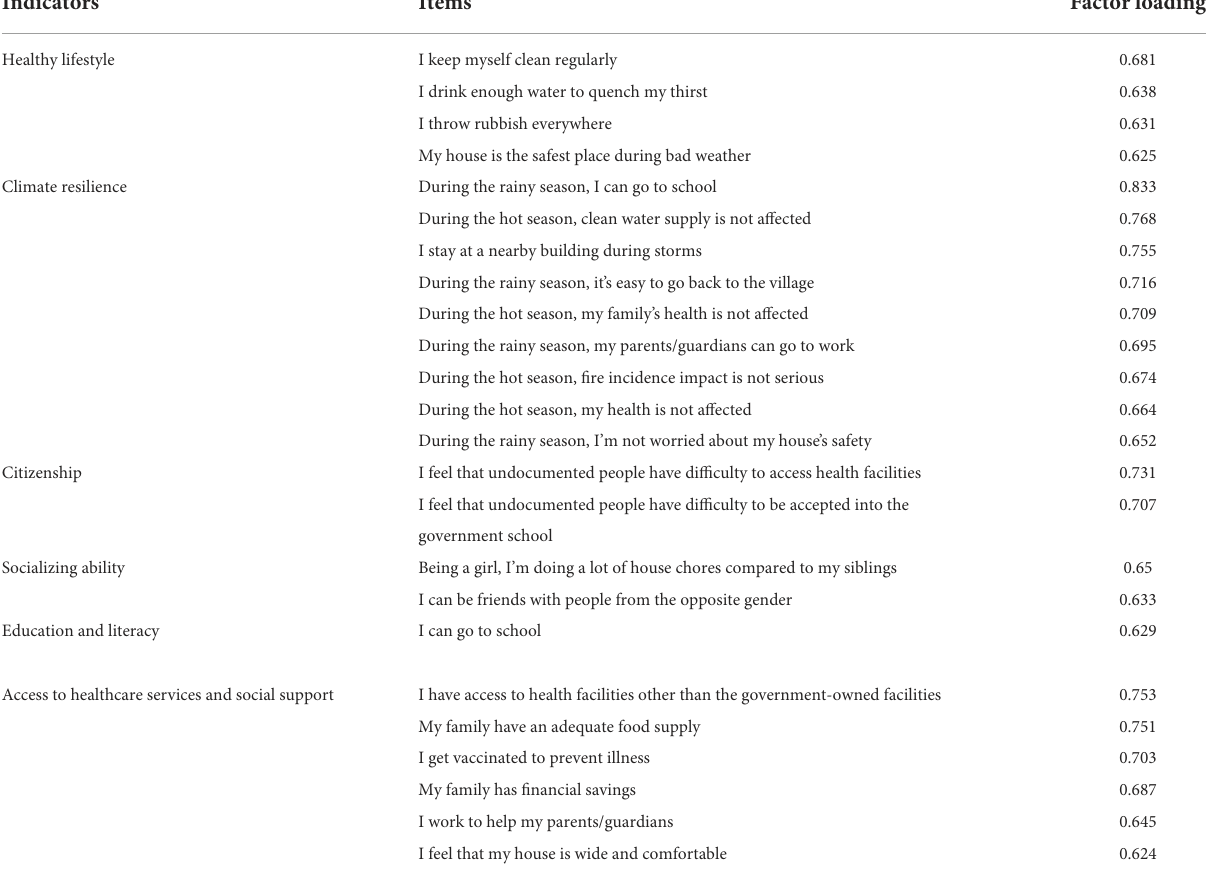
TABLE 7 Indicators and items with respective factor loadings for Pos Kuala Mu, Perak.